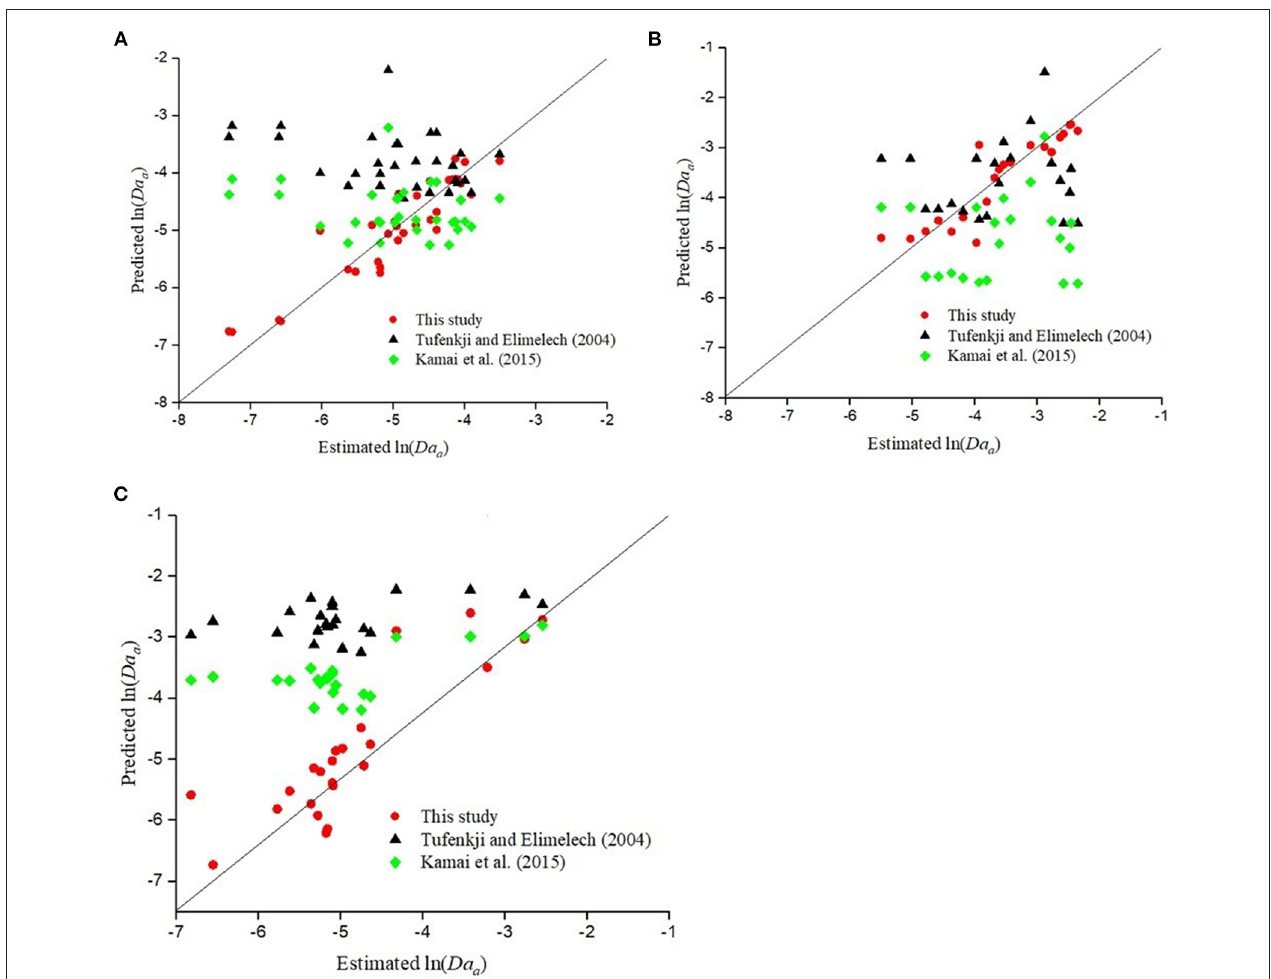
FIGURE 4 | Comparison of values of Da a predicted by the empirical equation developed in this study for (A) GO NPs (red circles, R 2 = 0.85) (B) AgNPs (red circles, R 2 = 0.824) (C) TiO 2 NPs (red circles, R 2 = 0.85) vs. the corresponding estimated values reported in the literature ( Supplementary Tables 1 – 3 , respectively) obtained by fitting column experimental data with a 1D mathematical model. Also shown in the figure are the values of Da a predicted by CFT with η 0 calculated using the model of Tufenkji and Elimelech (2004) for (A) GO NPs (black triangles, R 2 = 0.139), (B) AgNPs (black triangles, R 2 = 0.009), (C) TiO 2 NPs (black triangles, R 2 = 0.289) and Kamai et al. (2015) for (A) GO NPs (green diamonds, R 2 = 0.078), (B) AgNPs (green diamonds, R 2 = 0.007), (C) TiO 2 NPs (green diamonds, R 2 =